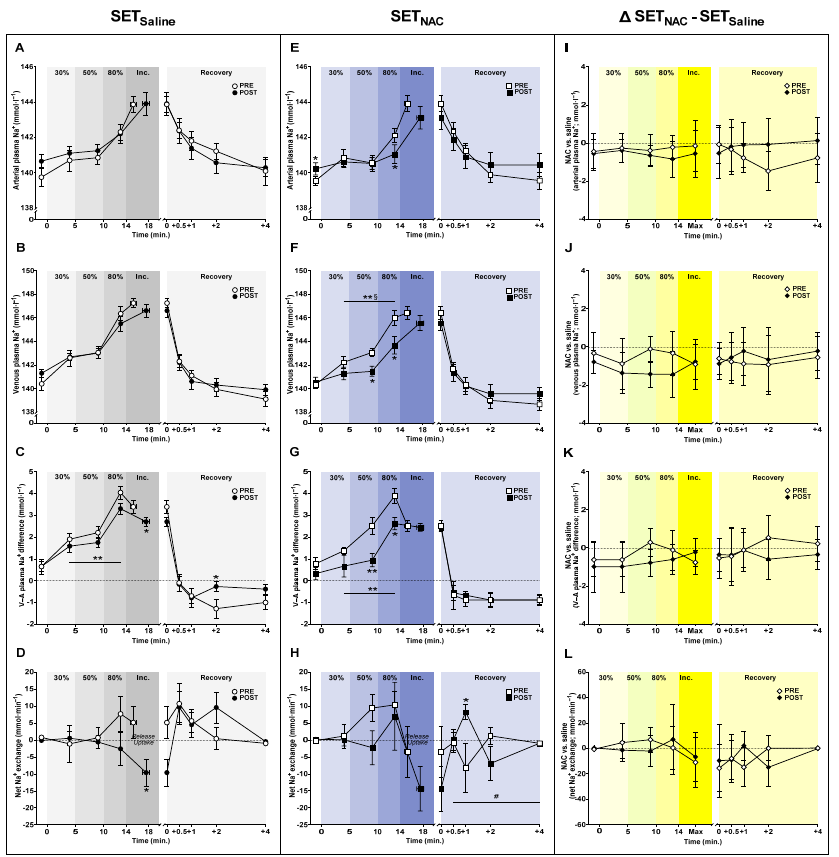
Figure 8. Effect of speed endurance training (SET) on plasma Na + shifts without and with N -acetyl- cysteine infusion. Plasma Na + concentrations ( A – C , E – G ) and net leg Na + exchange ( D , H ) before, during, and after knee-extensor exercise without (SET Saline , n = 10) and with N -acetylcysteine (SET NAC , n = 9) infusion as well as differences ( Δ ) between SET NAC and SET Saline ( I – L , n = 9) before (pre) and after (post) SET. ** Post different from pre ( p < 0.01). * Post different from pre ( p < 0.05). # Trial × time effect ( p < 0.05). § Trial × leg effect ( p < 0.05). Data are presented as mean ± SEM (SET Saline and SET NAC ) or mean ± 95% CI ( Δ SET NAC − SET Saline ). The cumulated net leg lactate - release during submaximal exercise was 6.8 mmol ( − 10.3 to − 3.3; p = 0.001) and 8.1 mmol ( − 13.2 to − 3.0; p = 0.006) lower after training in SET Saline and SET NAC , respectively (Table 3). The cumulated net leg lactate - release during the incremental part of the exercise to exhaustion was 7.7 mmol (4.0 to 11.4; p = 0.001) and 8.6 mmol (4.7 to 12.5; p = 0.001) higher after training in SET Saline and SET NAC , respectively. The cumulated net leg H + release during submaximal exercise was 7.9 mmol ( − 15.5 to − 0.3; p = 0.044) and 9.3 mmol ( − 17.6 to − 1.0; p = 0.032) lower after training in SET Saline and